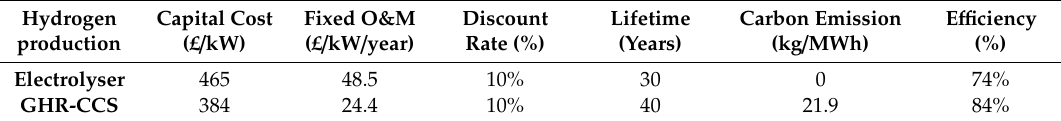
Table 3. Economic and operational parameters of the hydrogen production